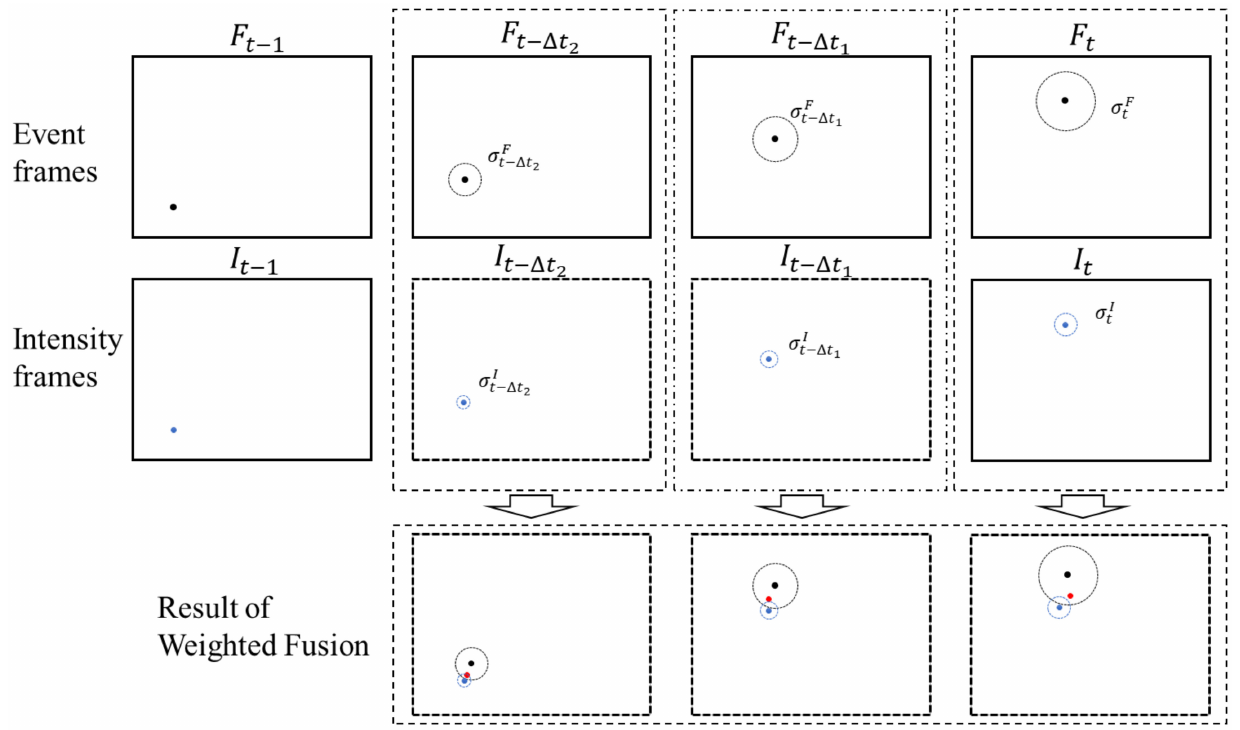
Figure 4. Illustration of the weighted fusion method for MHT-BP and